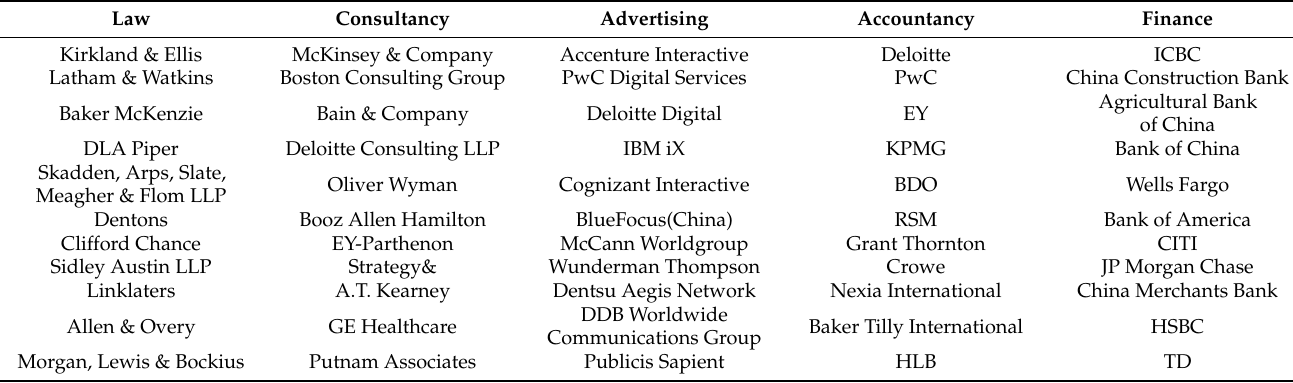
Table A1. 175 service firms’